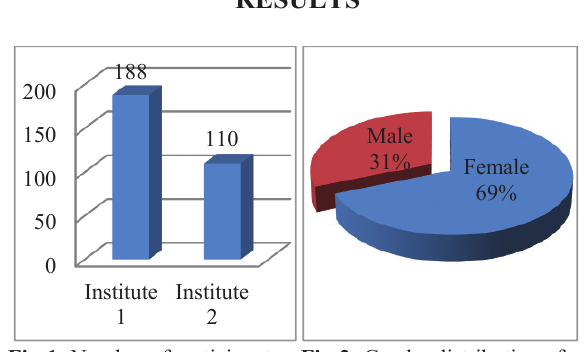
Fig-1: Number of participant Fig-2: Gender distribution of institute